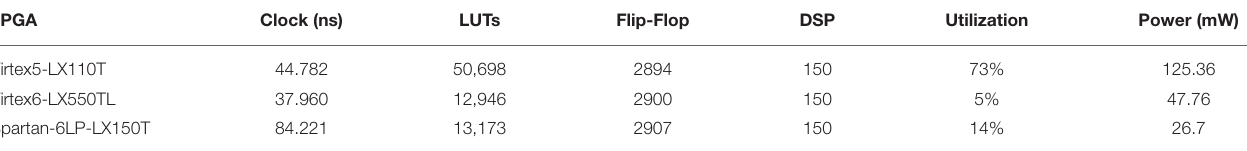
TABLE 2 | FPGA resource utilization for 30 neuron reservoir implementation on three different FPGAs.